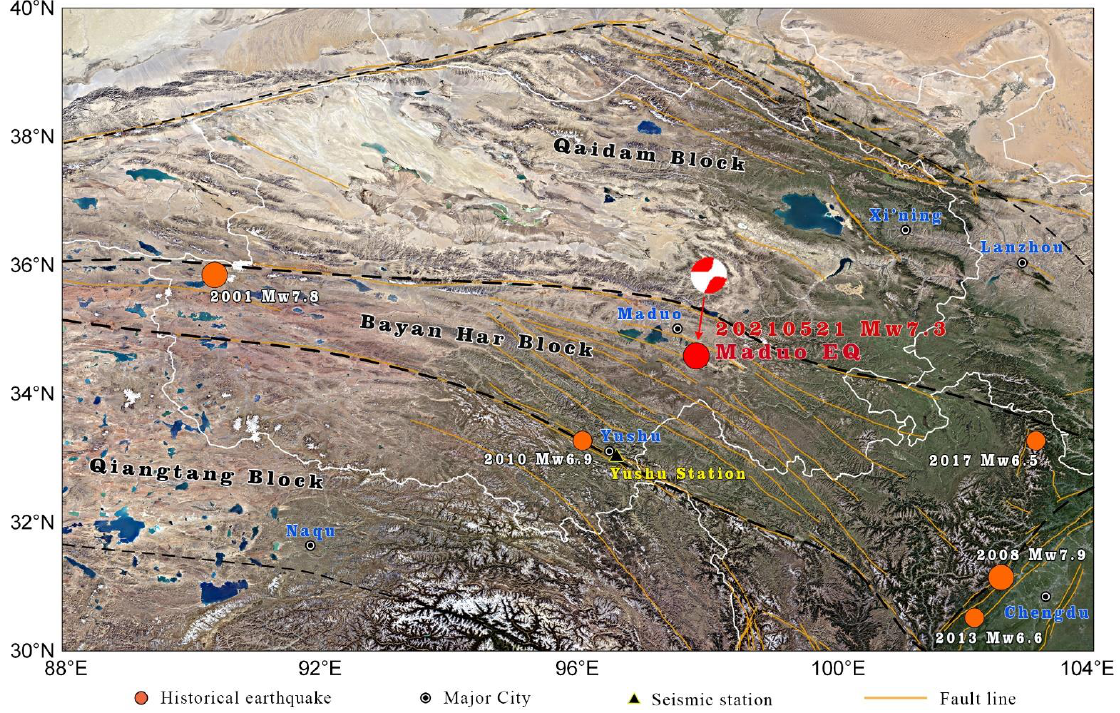
Figure 1. Visible image of the study area (from Google Earth). The red circle represents the epicenter of the Maduo earthquake, of which the focal mechanism was derived from the Global CMT Catalog. The orange circles stand for the historical large earthquakes (Mw ≥ 6.5) in the study area.